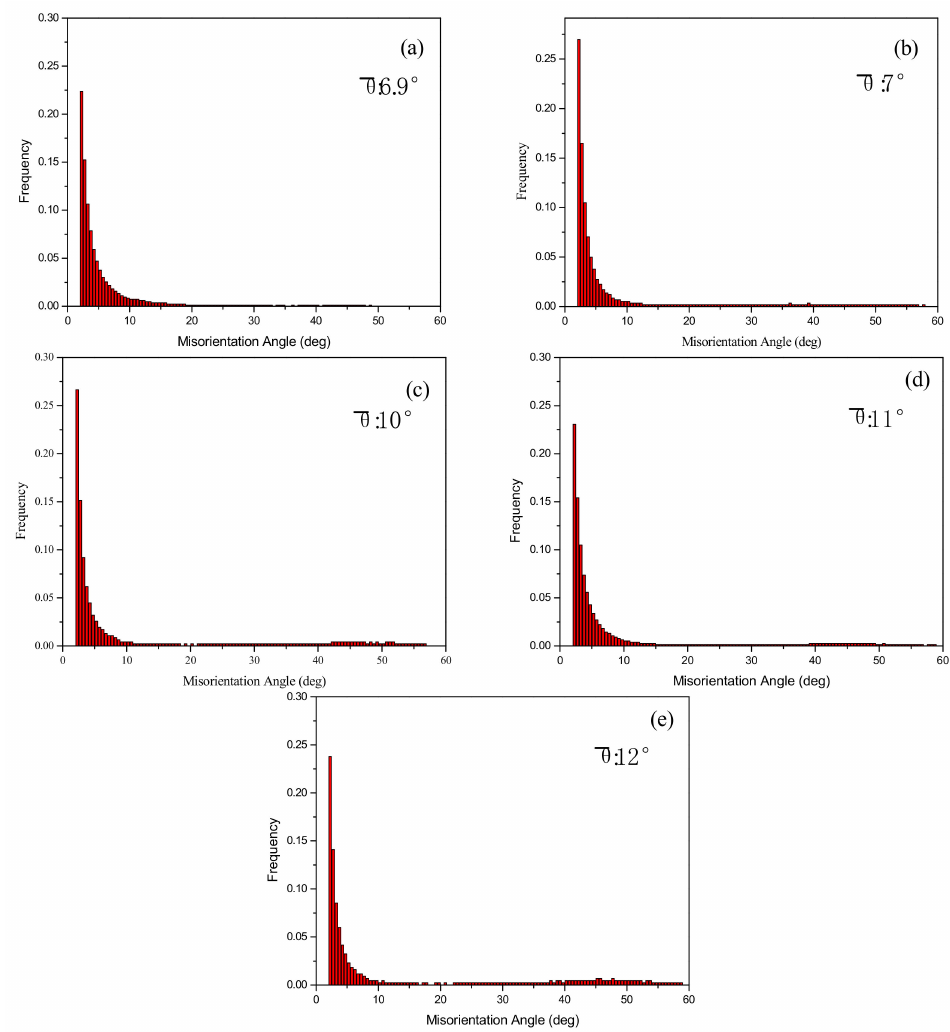
Figure 7. Distributions of misorientation angles of 7085 and TiC / 7085 after 80% rolling deformation ( a ) 7085; ( b ) 0.1 wt% TiC / 7085; ( c ) 0.3 wt% TiC / 7085; ( d ) 0.5 wt% TiC / 7085; ( e ) 1 wt% TiC /